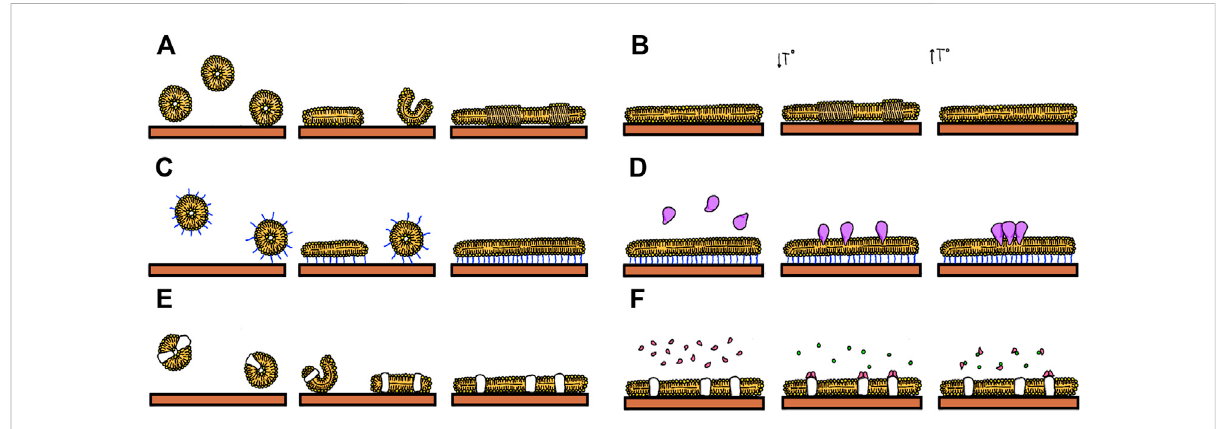
FIGURE 1 Events that can be studied using Supported Lipids Bilayers: (A) Formation by vesicle fusion. (B) Formation of lipid domains (C) Formation of tetheredbilayers (D) Insertionofproteins (E) Fusionofproteoliposomes (F) Followingbiomolecularinteractionssuchasthatbetweensolubleligands and membrane